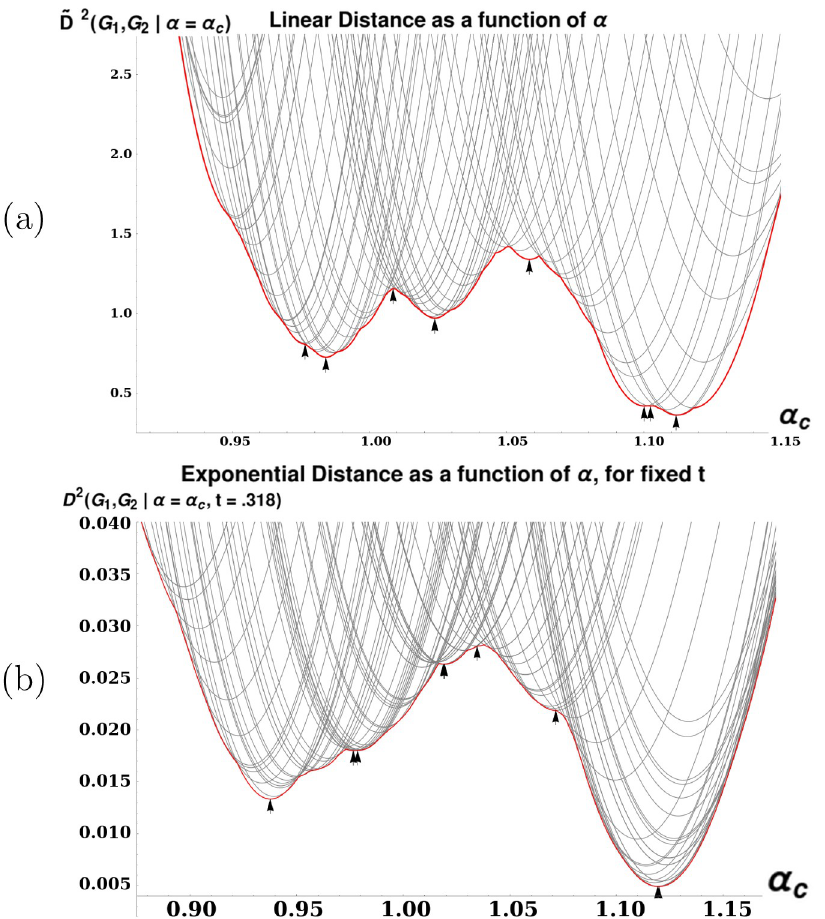
Algorithm 1. (b): As in (a), but with D 2 (Sq 7 , Sq 8 | t = .318) plotted instead of ~ D 2 . This t value is the location of the maximum in Fig